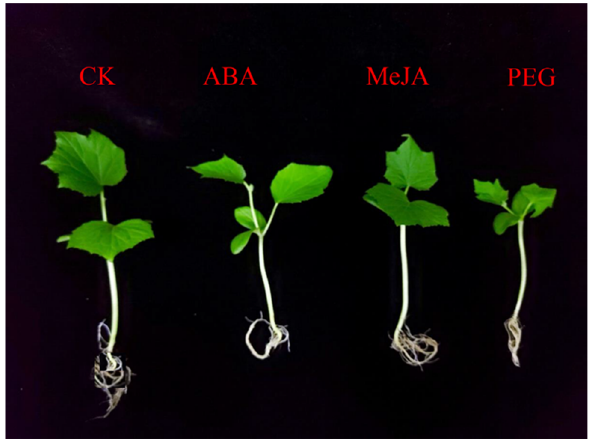
Figure 9. Plant morphology of cucumber seedlings under different treatments. Cucumber seedlings at the two-leaf stage were treated with 15% ( w / v ) PEG6000, 100 µM methyl jasmonate (MeJA), 100 µM ABA, and photographed 48 h after treatments.